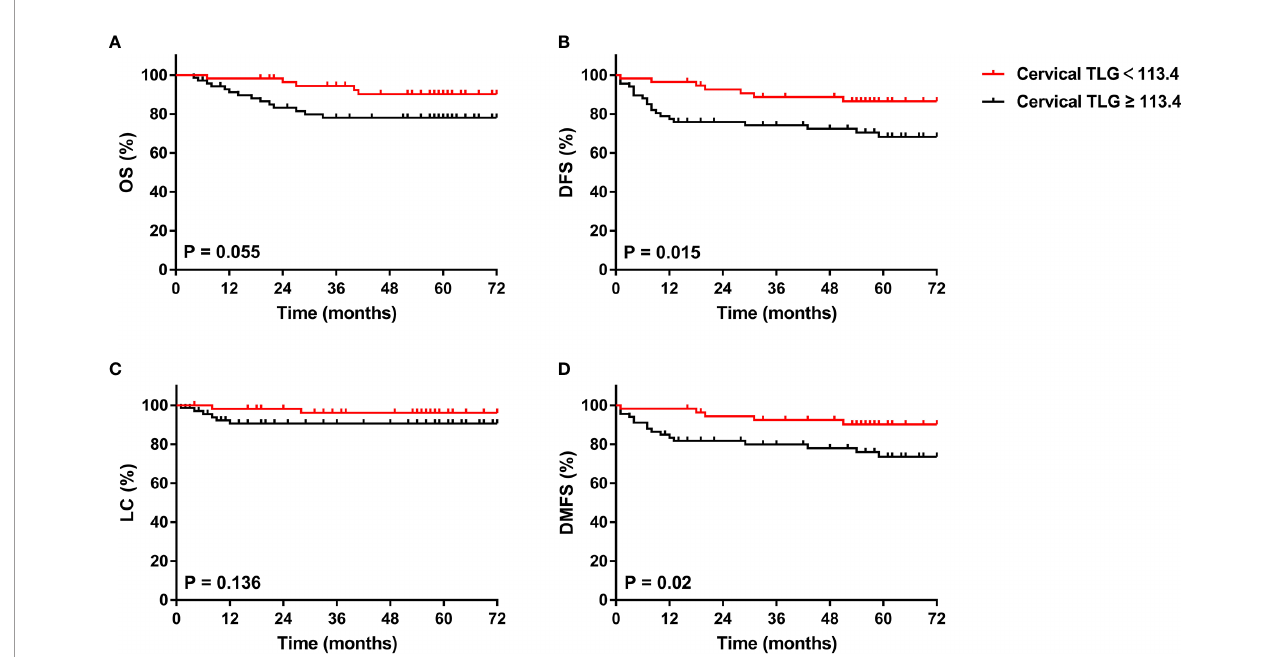
FIGURE 3 | Kaplan-Meier curves of OS (A) , DFS (B) , LC (C) , and DMFS (D) of all included patients with cervical cancer for cervical TLG. OS, overall survival; DFS, disease-free survival; LC, local control; DMFS, distant metastasis-free survival.